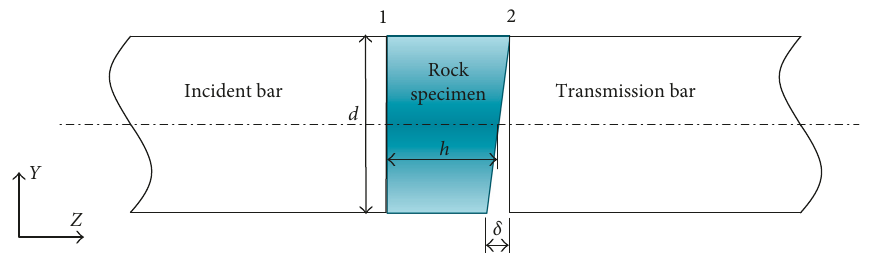
Figure 1: Nonparallel end-surface rock